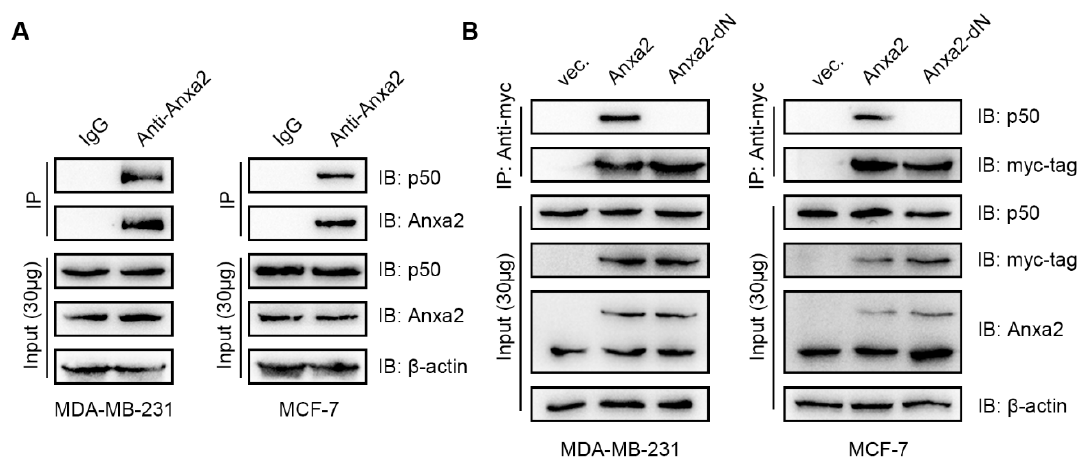
Figure 1. Anxa2 interacts with p50 in breast cancer cell lines. ( A ) An immuno-precipitation was performed with anti-Anxa2 antibody in protein extract from MDA-MB-231 cells and MCF-7 cells and immuno-precipitation with IgG was used as a negative control. ( B ) An immuno-precipitation was performed with anti-myc-tag antibody in protein extract from MDA-MB-231 cells and MCF-7 cells transfected with empty vector (vec.), Anxa2 and Anxa2-dN. A total of 30 µ g of whole-cell protein extract was loaded as input. All experiments were repeated for three times.